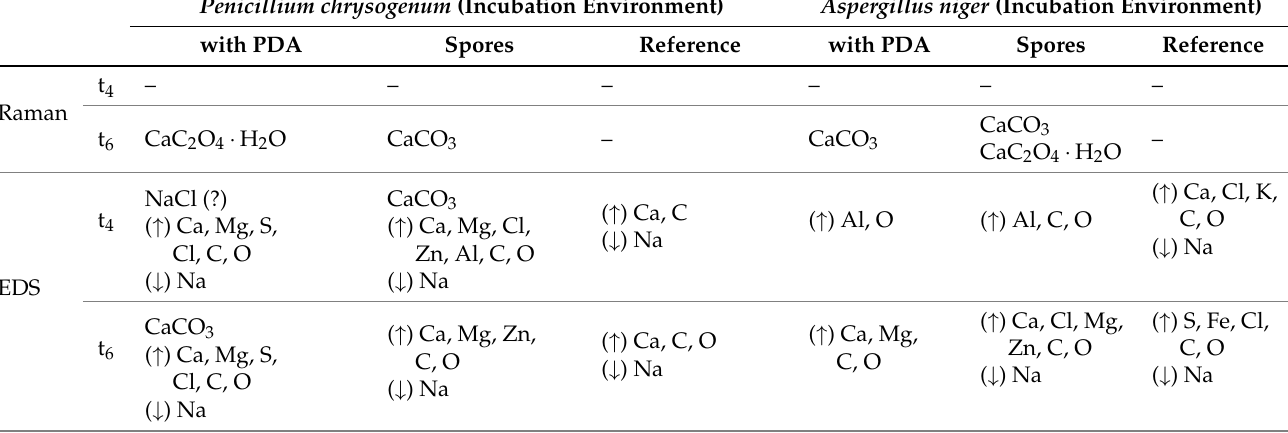
Table 3. Summary of the analysed chemical alterations analysed by Raman and EDS. ( ↑ ) enrichment; ( ↓ )